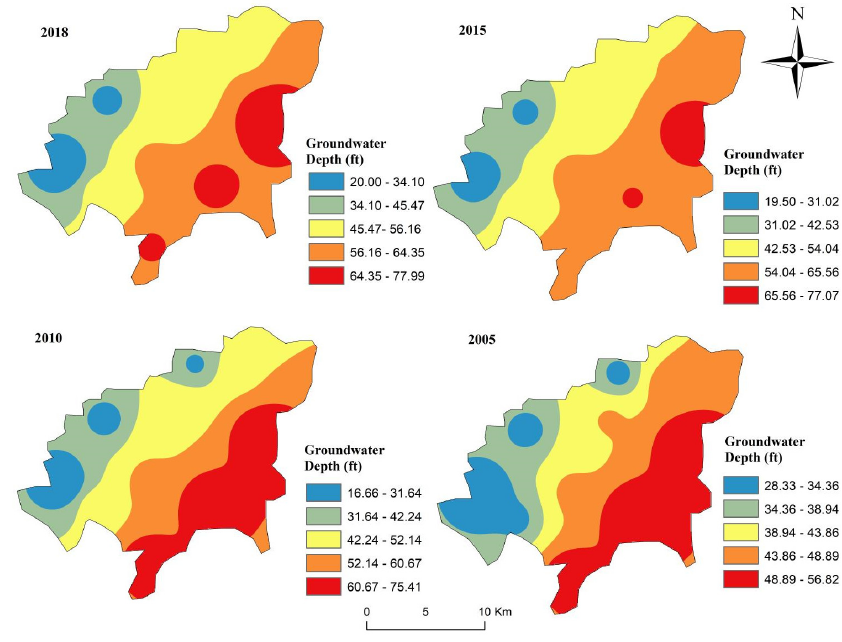
Figure 12 . Spatial variability in pre ‐ monsoon water table depth from 2005 to 2018.